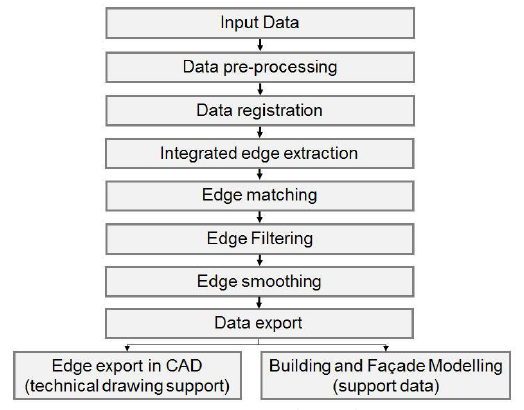
Figure 1. Algorithm workflow of the